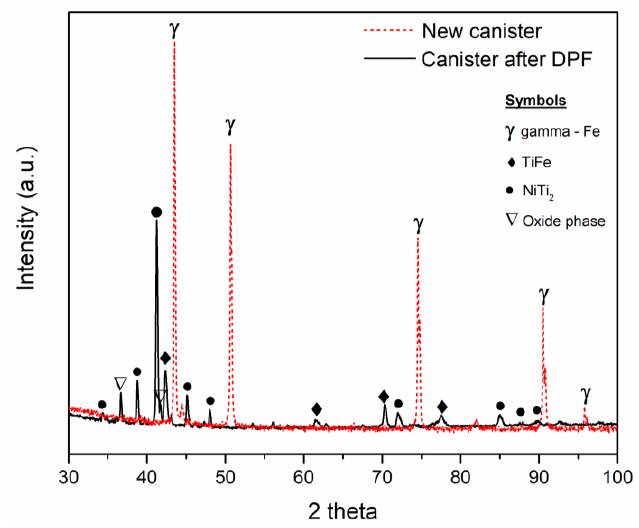
Figure 7. XRD pattern of the stainless steel canister inner wall before and after DPF.